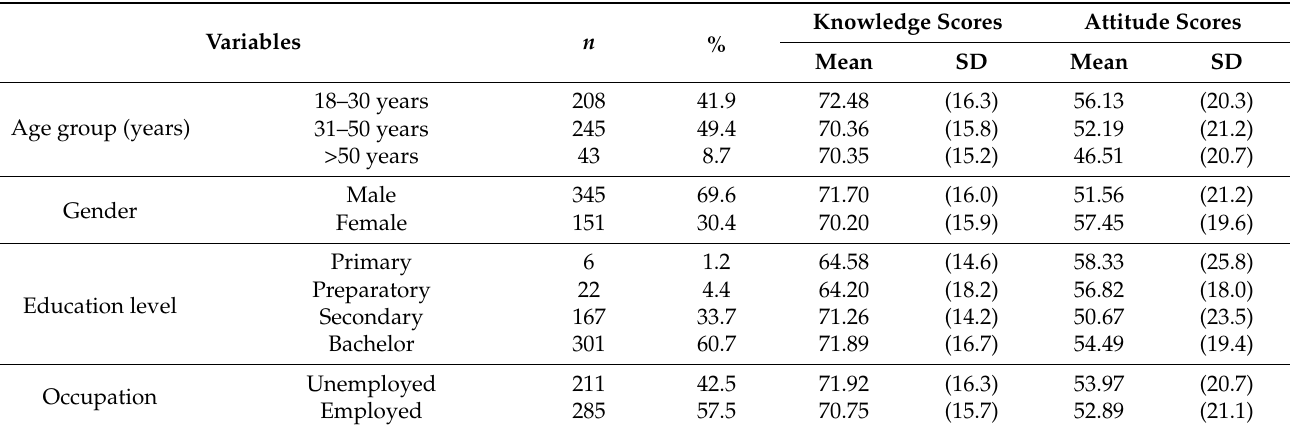
Table 1. Study participants’ background characteristics and knowledge and attitude scores according to some selected characteristics ( n =